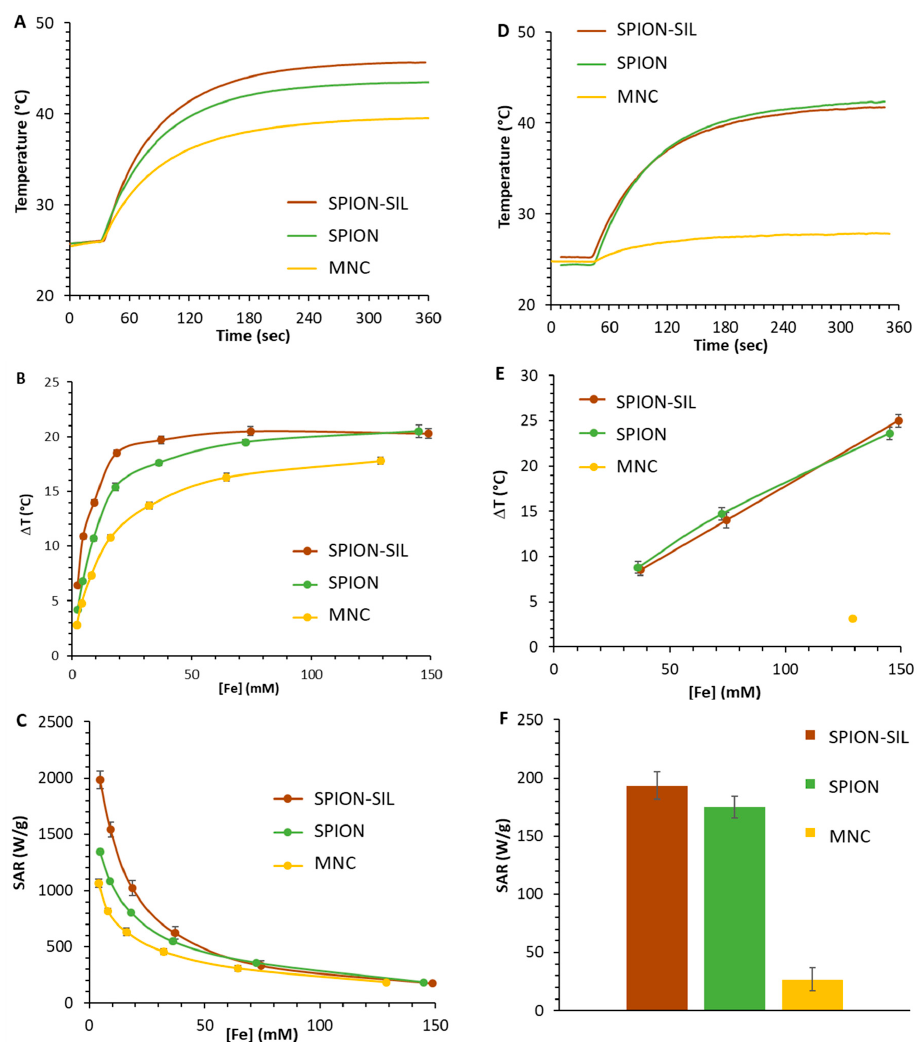
Figure 3. Temperature elevation measurements after ( A – C ) photothermia (wavelength of 808 nm, power density of 0.3 W/cm²) and ( D – F ) magnetic hyperthermia (frequency 470 kHz, field 18 mT). ( A ) Representative temperature increase as a function of time for the suspension at iron concentration [Fe] = 30 mM; ( B ) average temperature increase as function of the iron concentration reached after 5 min of laser exposure; ( C ) average specific absorption rate (SAR) as a function of the iron concentration in different nanomaterials; ( D ) representative temperature increase as a function of time for the suspension at iron concentration [Fe] = 130 mM; ( E ) average temperature increase as a function of the concentration under magnetic hyperthermia; and ( F ) average SAR as a function of the iron concentration in different nanomaterials under magnetic hyperthermia.